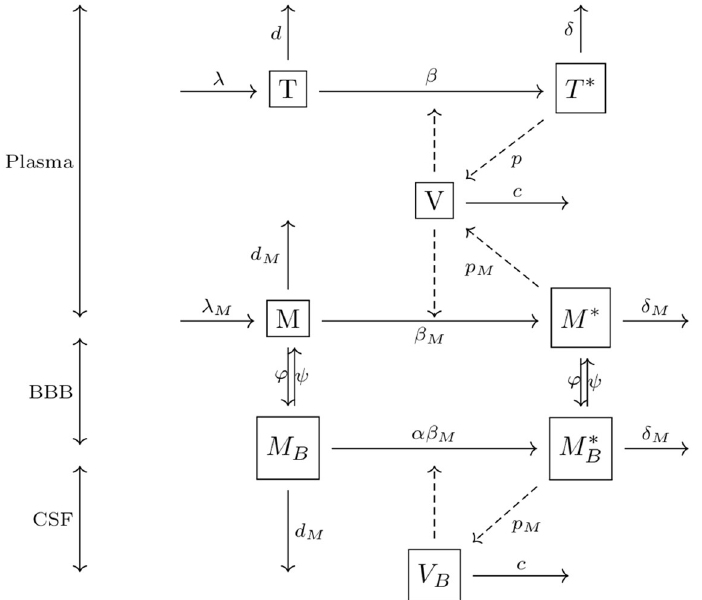
Fig 1. The schematic diagram of the model representing HIV-1 infection in the brain. The boxes represent a cell population, the solid arrows represent transport from one population to another, and the dashed arrows represent the cause for the corresponding